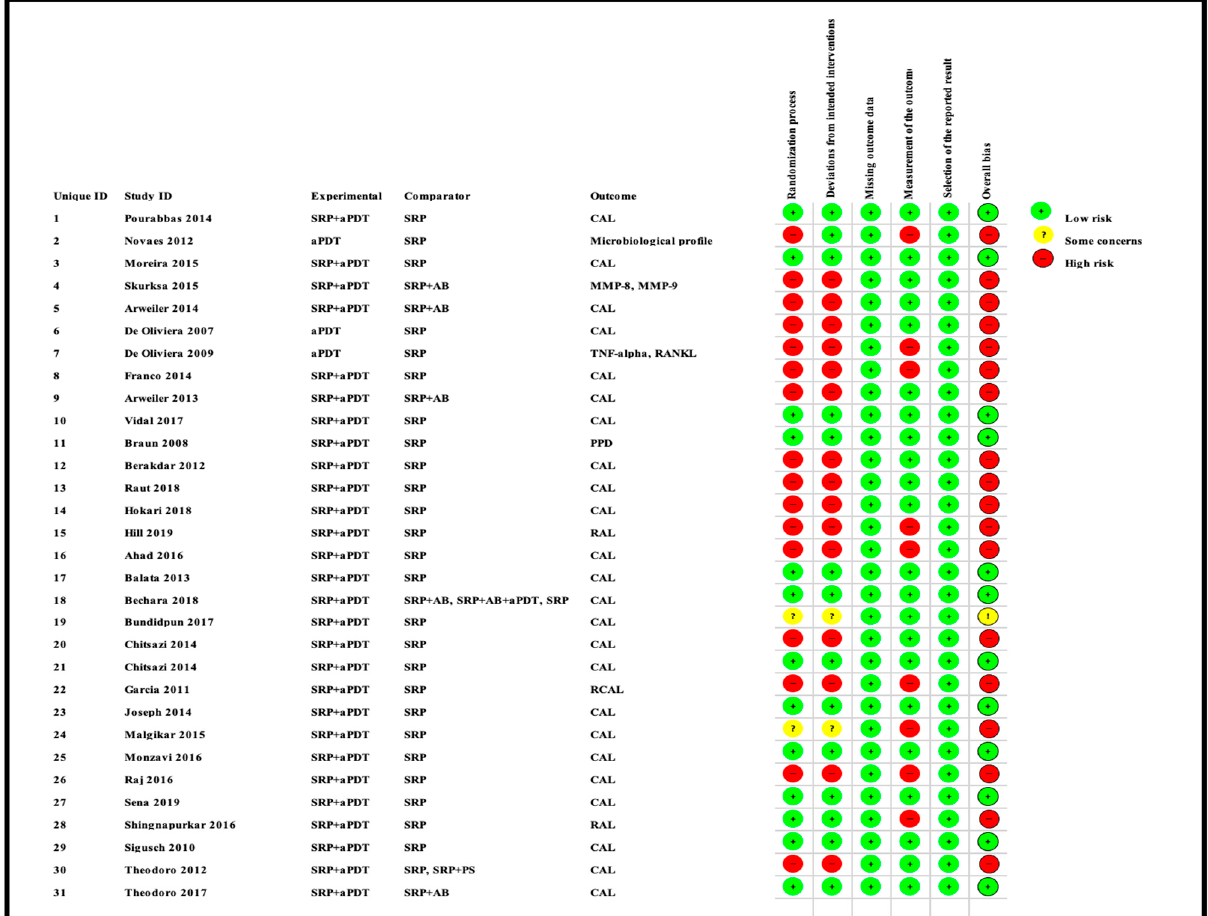
Figure 4. Risk of Bias assessment summary of the included studies based on the consensual answers across two individual assessors (S.D. and R.H.).